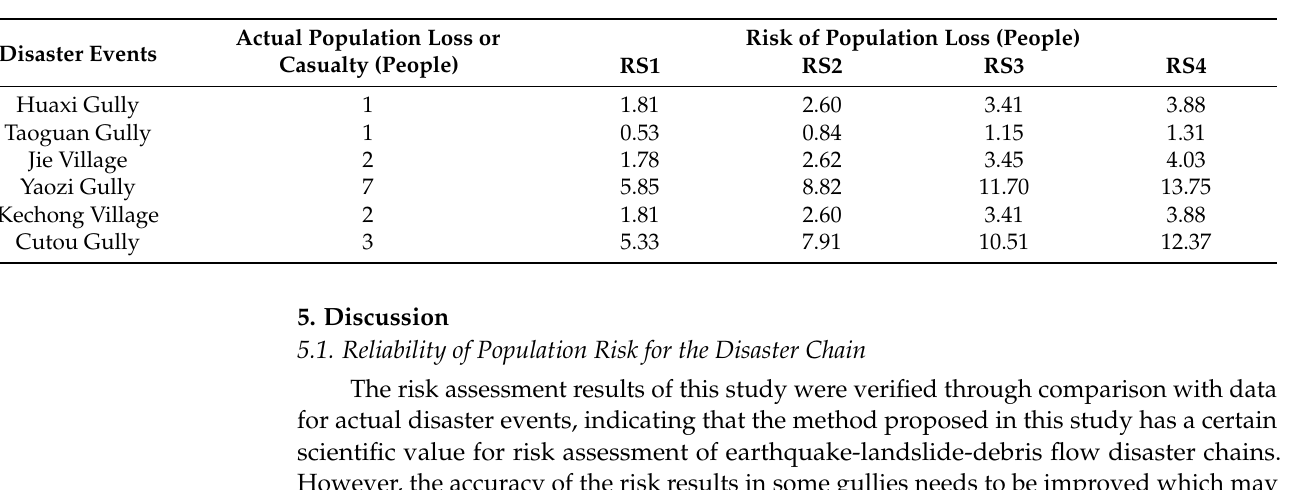
Figure 11. Spatial distribution of the population loss risks posed by debris flows in Wenchuan under the four rainstorm scenarios. Table 5. Comparison of the simulated and actual population losses caused by debris